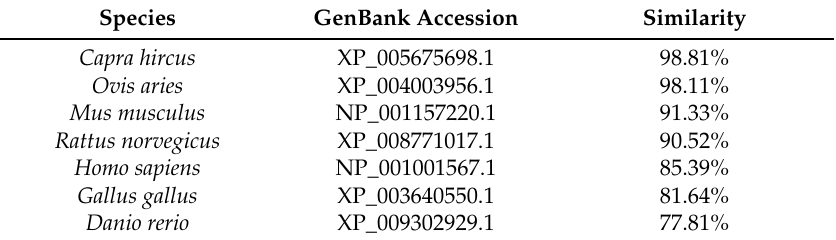
(Table 1): Homo sapiens (85.39%), Rattus norvegicus (90.52%), Mus musculus (91.33%), Gallus gallus (81.64%), Danio rerio (77.81%), Capra hircus (98.81%) and Ovis aries (98.11%). The results suggested that the PDE9A gene was extremely conserved within mammalian species. Table 1. Comparative analysis of PDE9A amino acid sequence of different